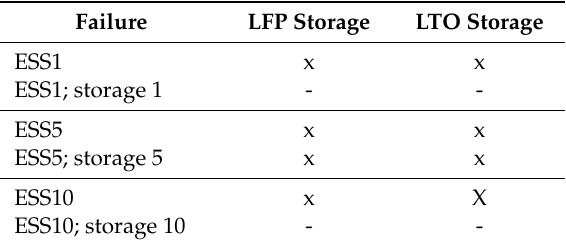
Table 8. Matrix of test cases, failure of one ESS including storage or not, for di ff erent storage systems option; business continuity (x), service interruption (-).